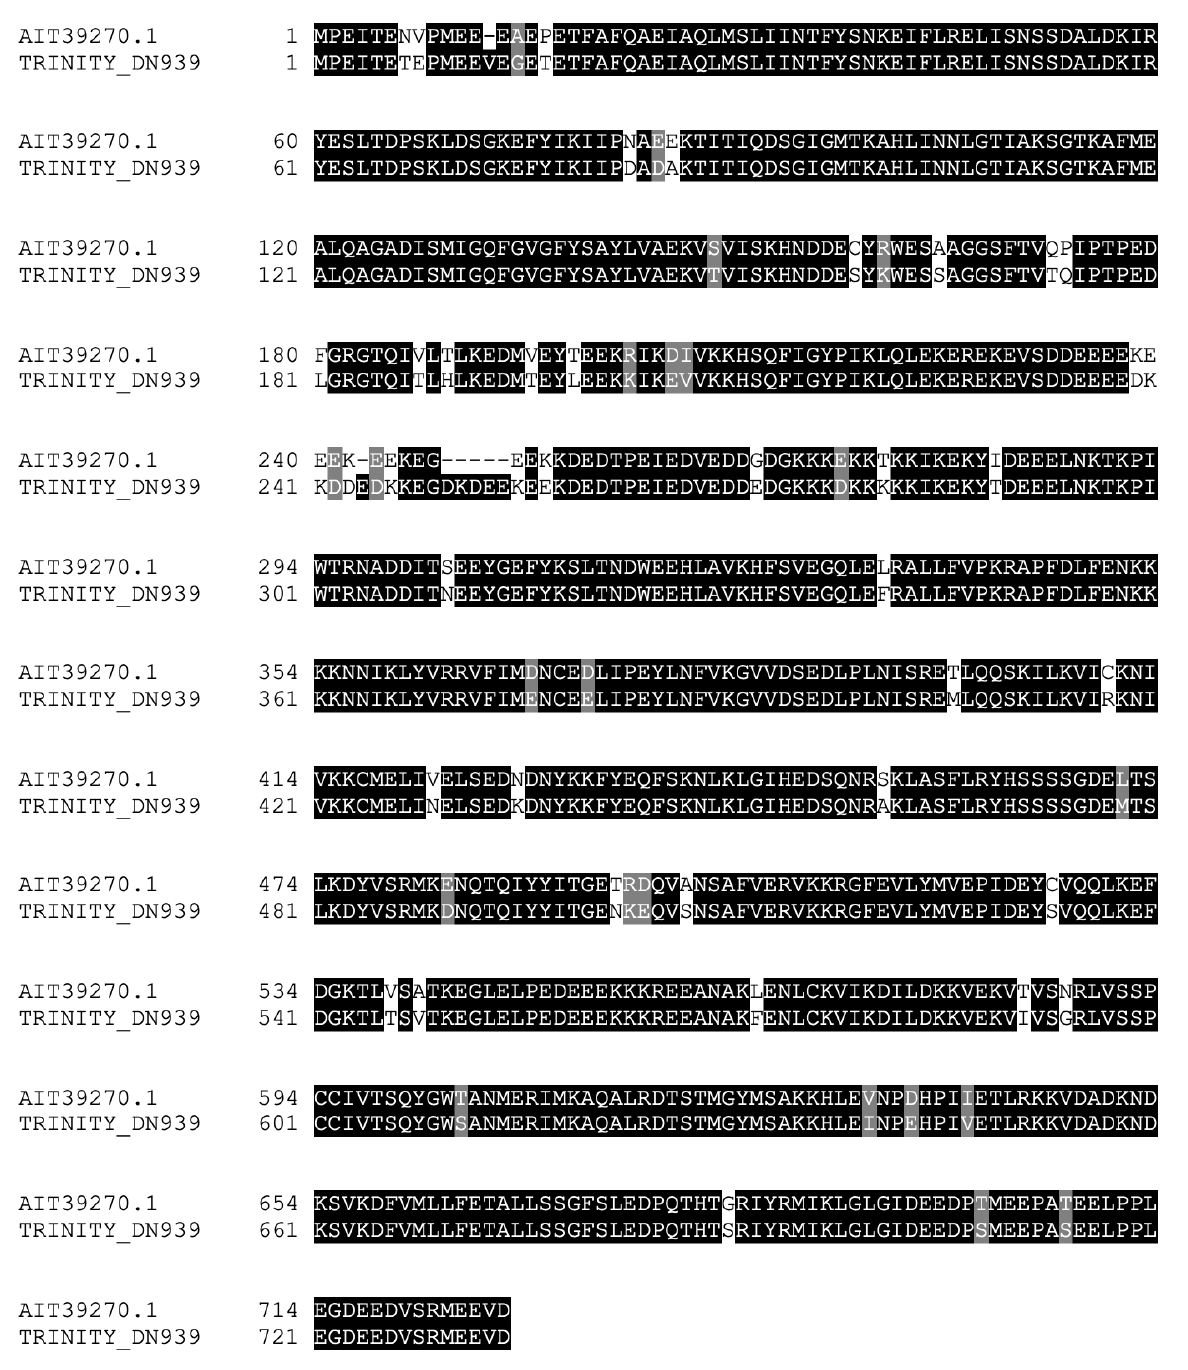
Figure 3. Alignment of Hsp90 homolog identified in the RNC transcriptome with a Hsp90 sequence from A. japonicus .